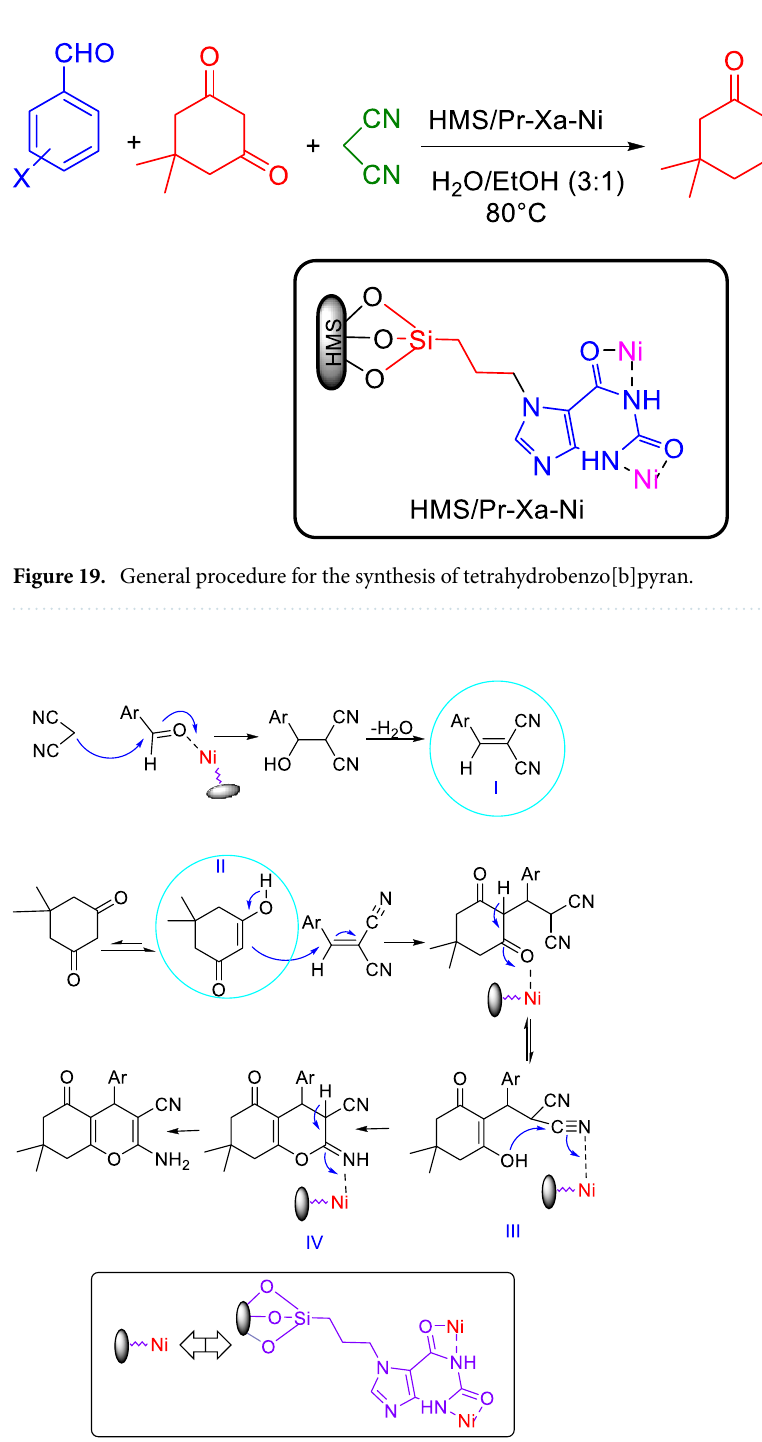
Figure 20. The possible mechanism for the synthesis of